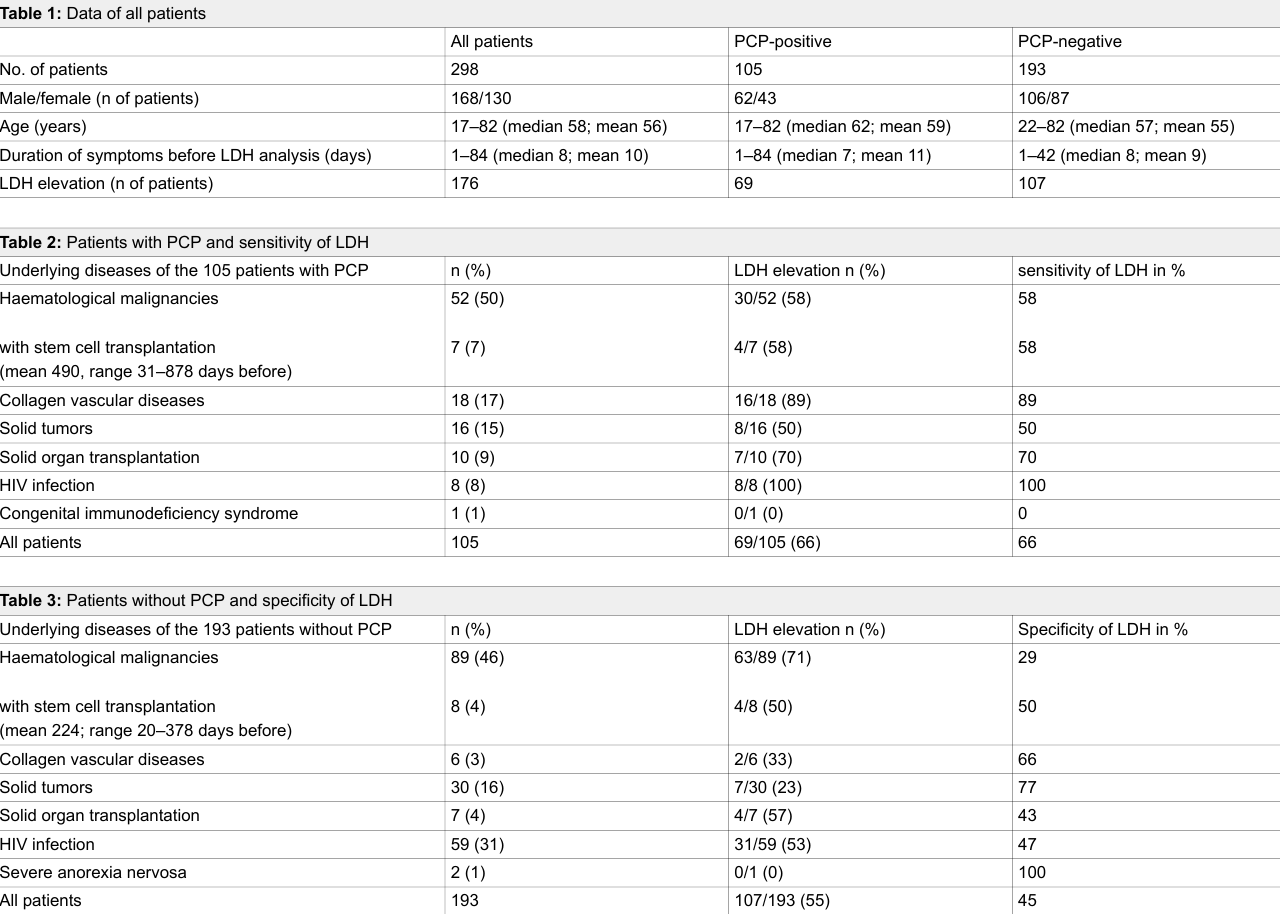
Table 1: Data of all patients